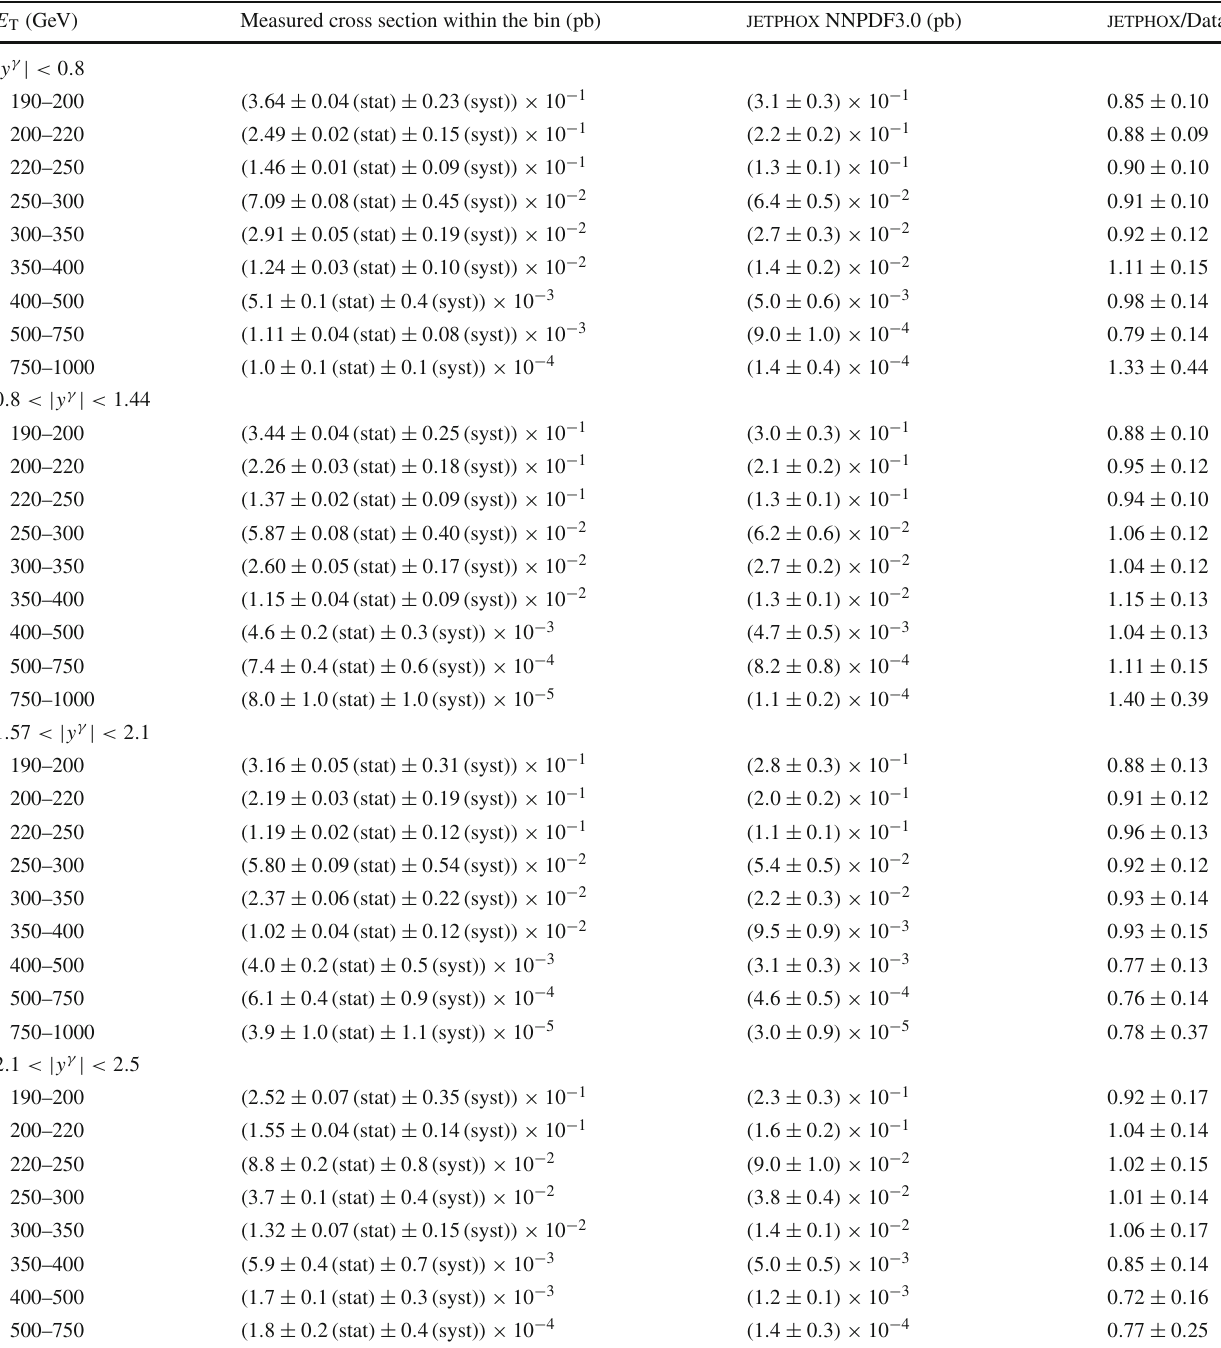
Table 2 Measured and predicted differential cross section for isolated- with the NNPDF3.0 PDF set. The ratio of the jetphox predictions to photon production, along with the statistical and systematical uncer- data are listed in the last column, with the total uncertainty estimated tainties in the various E T and y bins. Predictions use jetphox at NLO assuming uncorrelated experimental and theoretical uncertainties E T (GeV) Measured cross section within the bin (pb) jetphox NNPDF3.0 (pb) jetphox